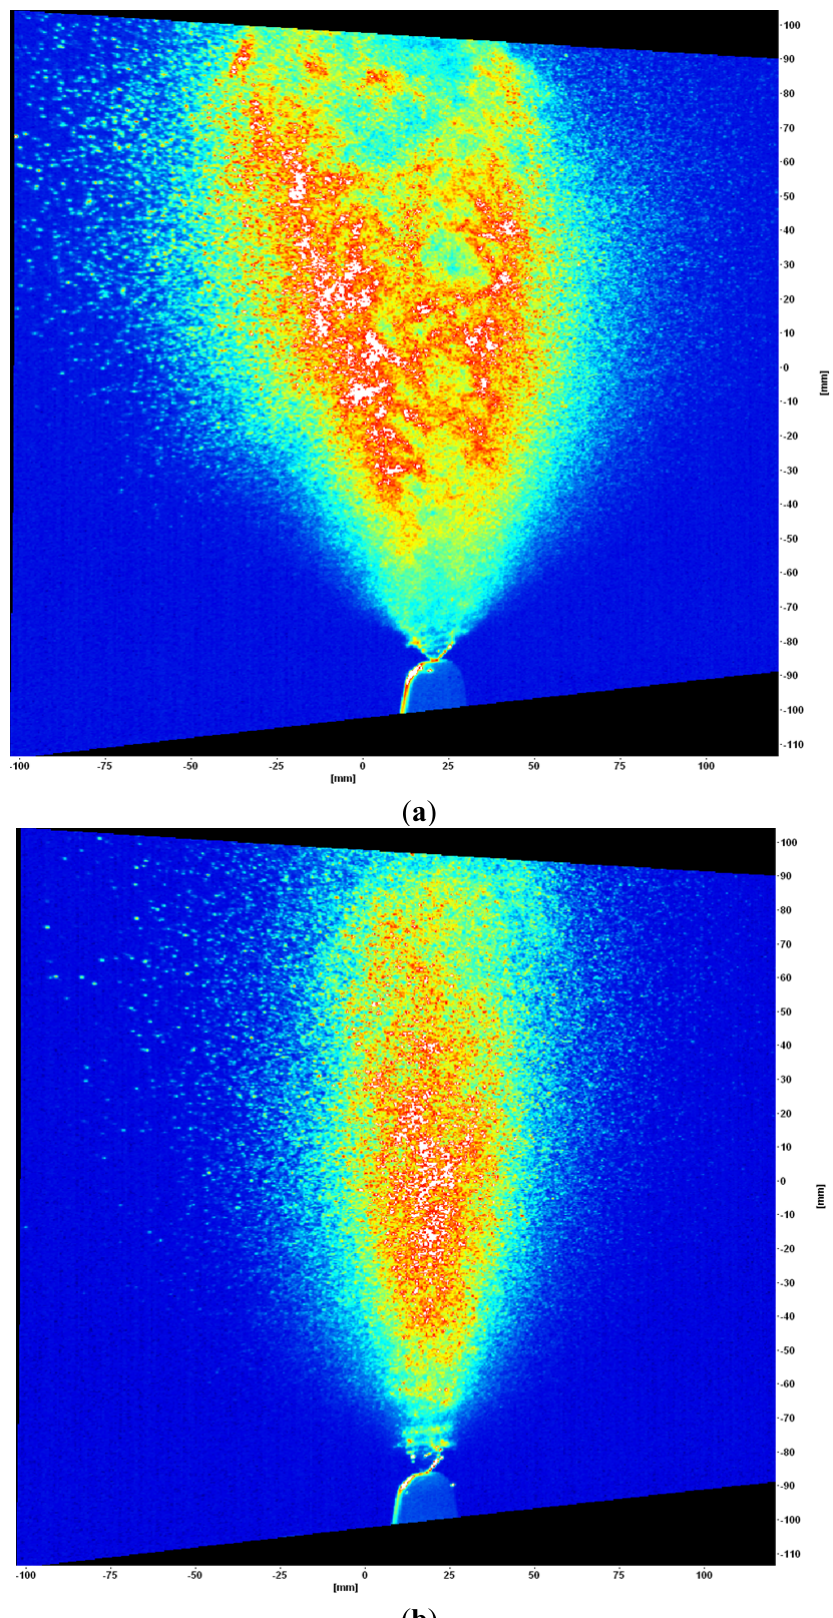
Figure 4. The influence of viscosity on the plume geometry. ( a ) Water; ( b ) 1% sodium carboxymethyl cellulose (NaCMC); ( c ) 2% NaCMC; ( d ) 3% NaCMC; ( e ) 4% NaCMC; and ( f ) 5% NaCMC; the device was actuated